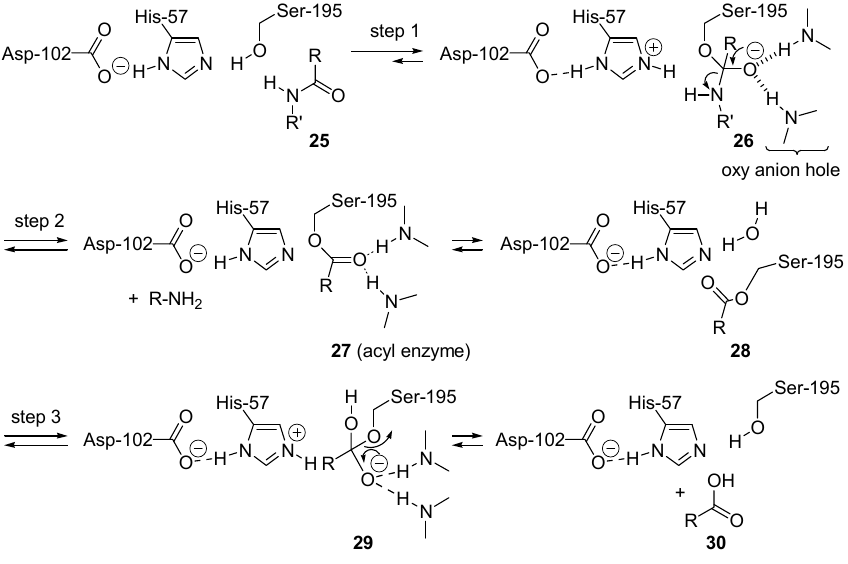
Scheme 16. Chymotrypsin ‐ catalyzed peptide bond cleavage: an example of covalent catalysis by